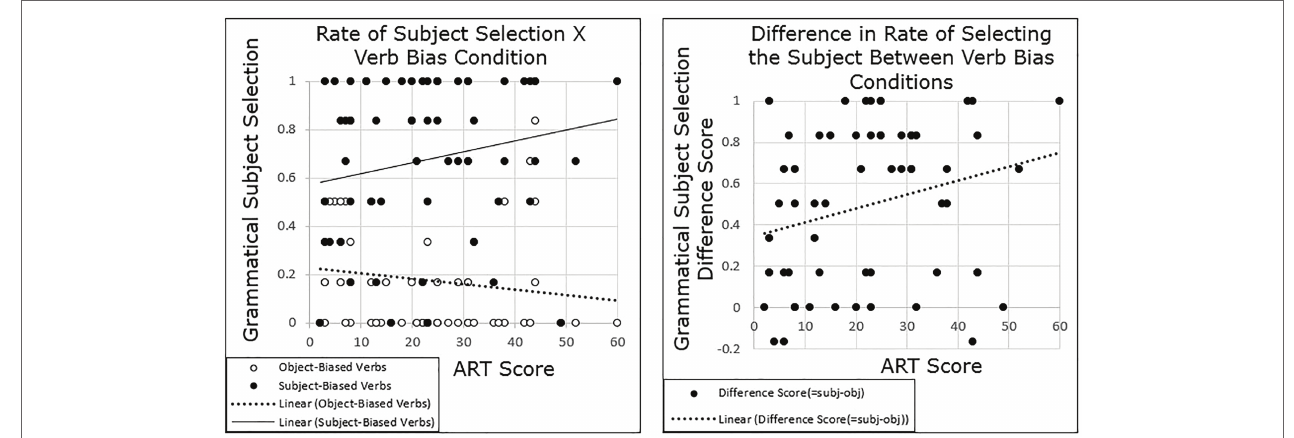
FIGURE 4 | Experiment 3 results: participants with higher ART scores show a stronger semantic bias than those with lower ART